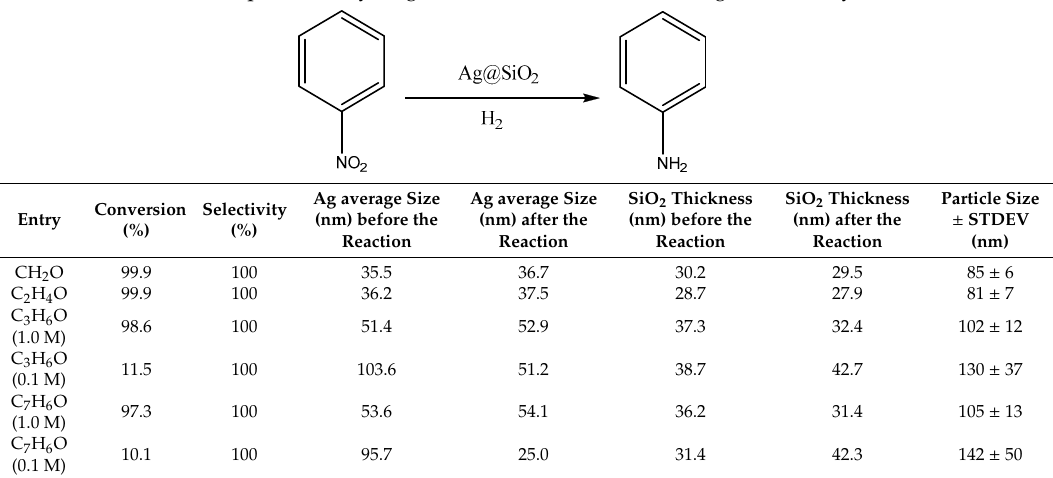
Table 1. Properties of hydrogenation reactions over fresh Ag@SiO 2 catalyst.